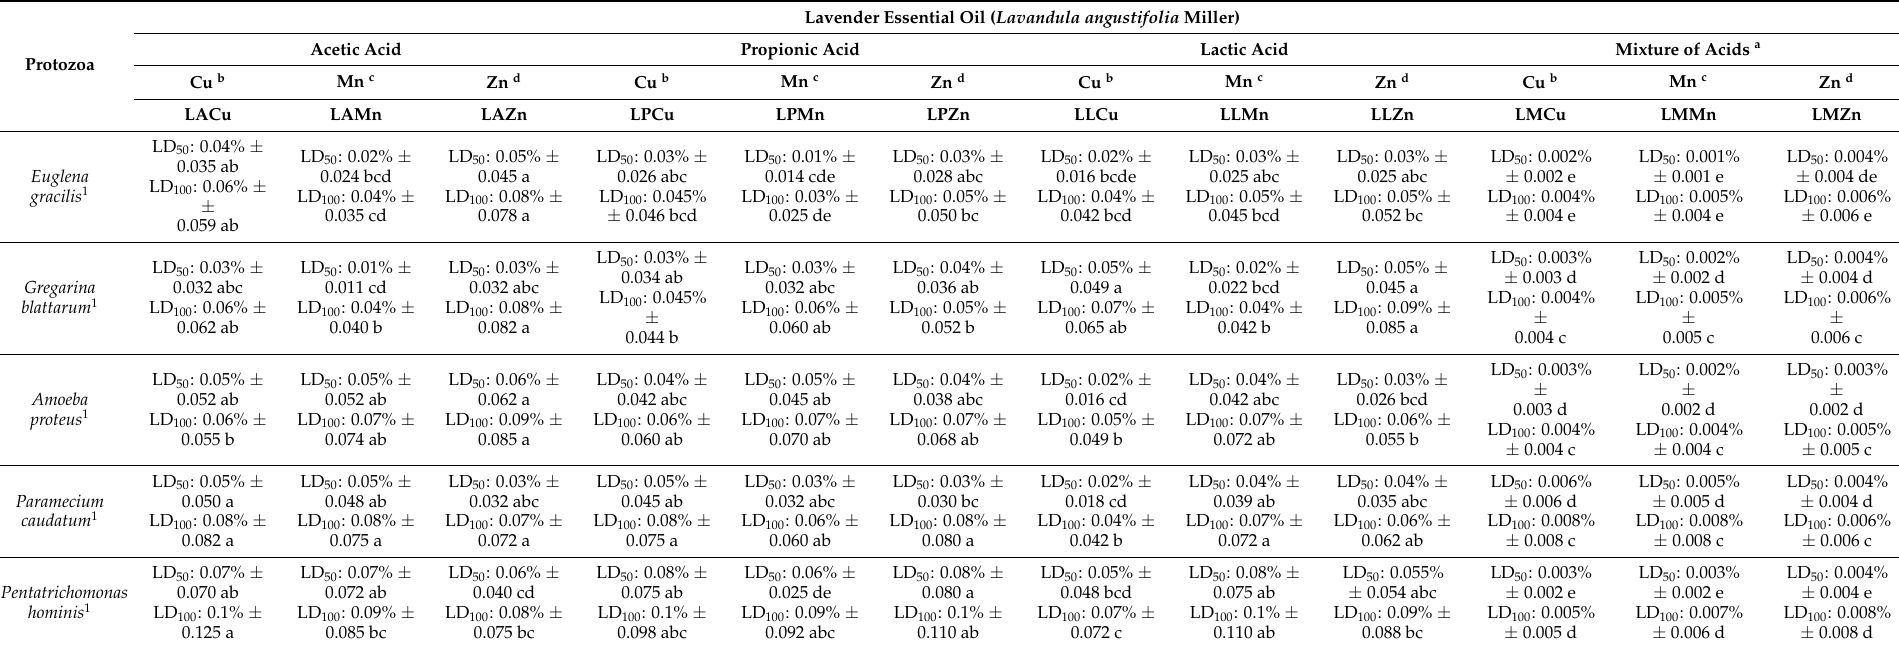
Table 9. LD 50 , LD 100 values of lavender essential oil ( Lavandula angustifolia Miller) (L), organic acids (Acetic acid—A, Propionic acid—P, Lactic acid—L, Mixture of acids—M) and metal ion against selected